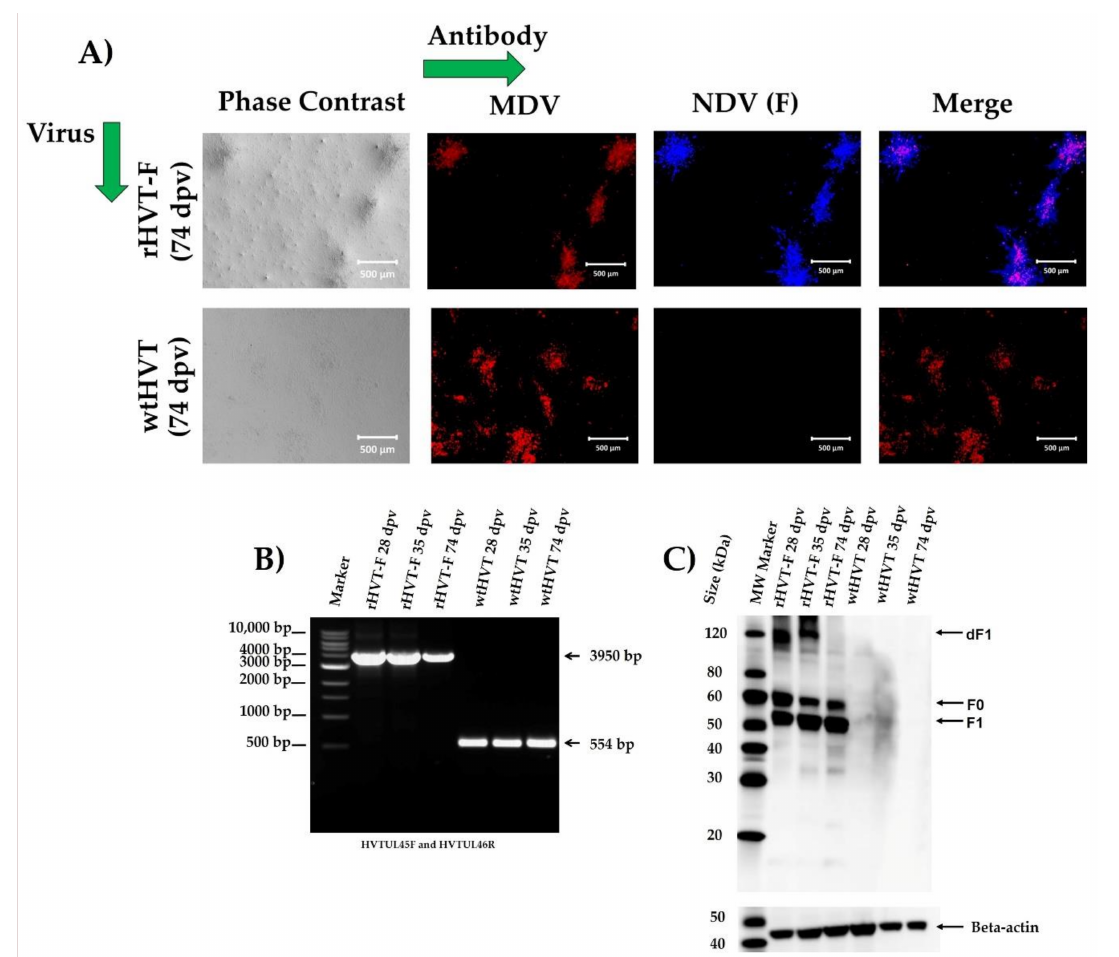
Figure 6. Detection of the replication and stability of rHVT-F virus in vivo. The isolation of rHVT-F and wtHVT from lymphocytes was confirmed by IFA, PCR, and Western blot analysis at 28, 35, and 74 dpv. A pool of peripheral blood lymphocytes (PBLs) from chickens ( n = 5) was used to isolate each virus, but only a representative image from each virus is shown. ( A ) The IFA was made in CEF cells infected with the isolated viruses by staining with anti-NDV chicken serum, followed by goat anti-chicken IgY H&L Alexa Fluor ® 405 (blue fluorescence). HVT was detected with a mouse antibody against MDV (B149M), followed by goat anti-mouse IgG H&L Alexa Fluor ® 594 (red fluorescence) and visualized by fluorescence and bright-field microscopy: 50 × magnification, all scale bars represent 500 µ m). ( B ) The genetic stability of isolated viruses was detected from infected CEF cells, so viral DNA was extracted and analyzed by PCR with primers HVT UL45F and HVT UL46R. From the left to the right are MW marker (lane 1), extracted DNA from CEF cells infected with the isolated viruses: rHVT-F virus at 28 (lane 2), 35 (lane 3), 74 dpv (lane 4), as well as wtHVT virus at 28 (lane 5), 35 (lane 6), 74 dpv (lane 7). The molecular sizes are indicated to the left of the gel in the bp. The black arrow indicates the MW expected of the band. ( C ) Expression of the NDV F protein was evaluated by Western blot analysis in CEF cells infected with isolated viruses using a specific rabbit polyclonal antibody against the NDV F protein as a primary antibody and a mouse anti-rabbit IgG antibody conjugated to HRP as a secondary antibody. From the left to the right are MW marker (lane 1), cell lysates from CEF cells infected with the isolated viruses: rHVT-F virus at 28 (lane 2), 35 (lane 3), 74 dpv (lane 4) and wtHVT virus at 28 (lane 5), 35 (lane 6), 74 dpv (lane 7). The black arrow indicates a ~59 kDa band corresponding to the inactive precursor (F0), a band ~52 kDa corresponding to cleaved subunit (F1), and a band ~120 kDa corresponding to the F1 dimer (dF1) of the NDV F protein. The Beta-actin protein (~42 kDa) was used as a loading control in lysate